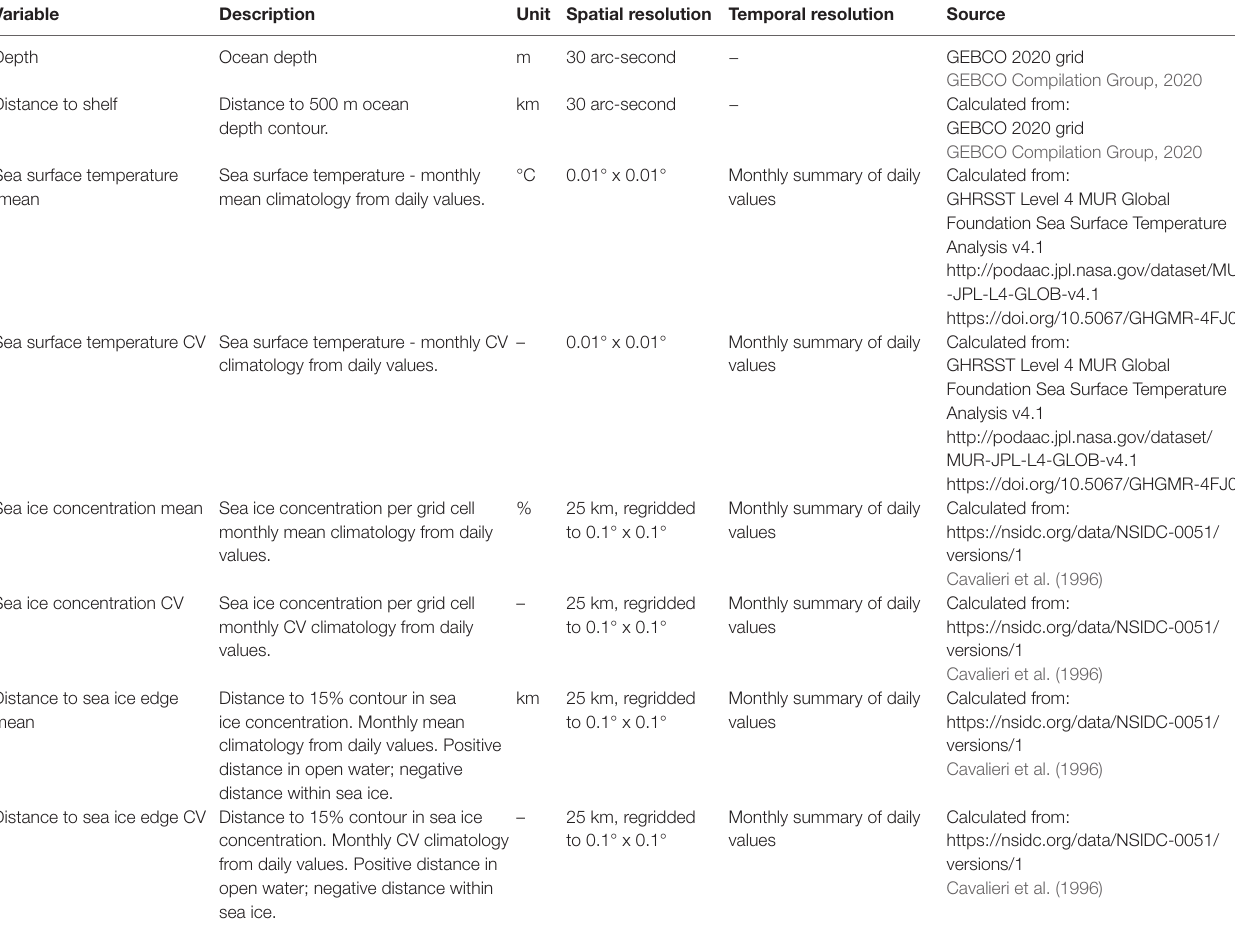
TABLE 1 | Environmental covariates used as predictors of whale behavioural state in spatial random forest models.